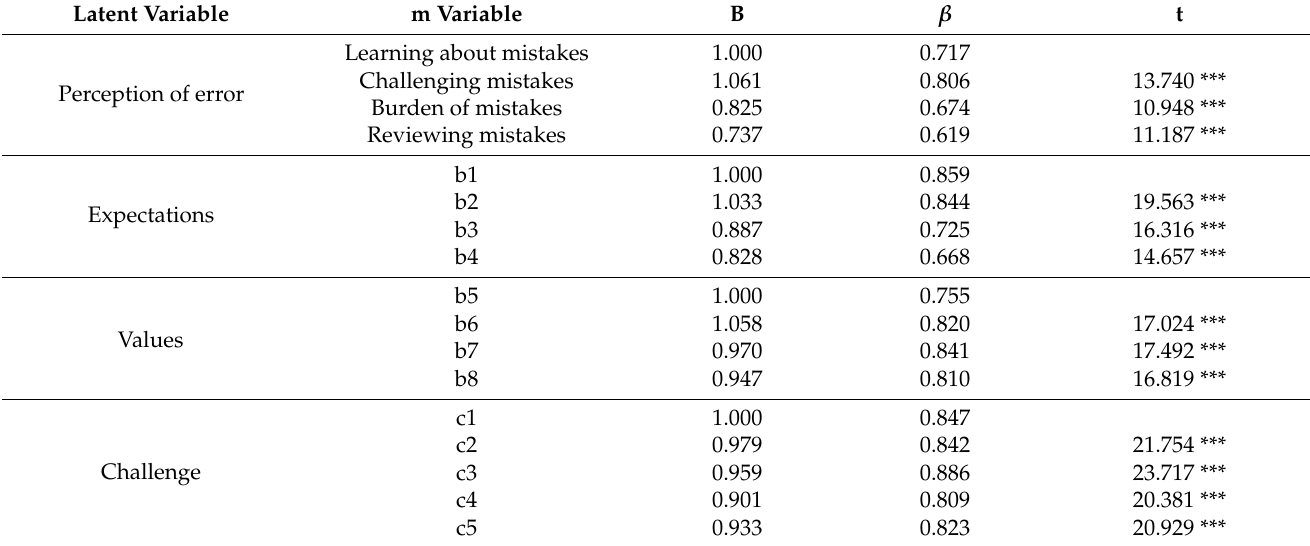
Table 5. Measurement model